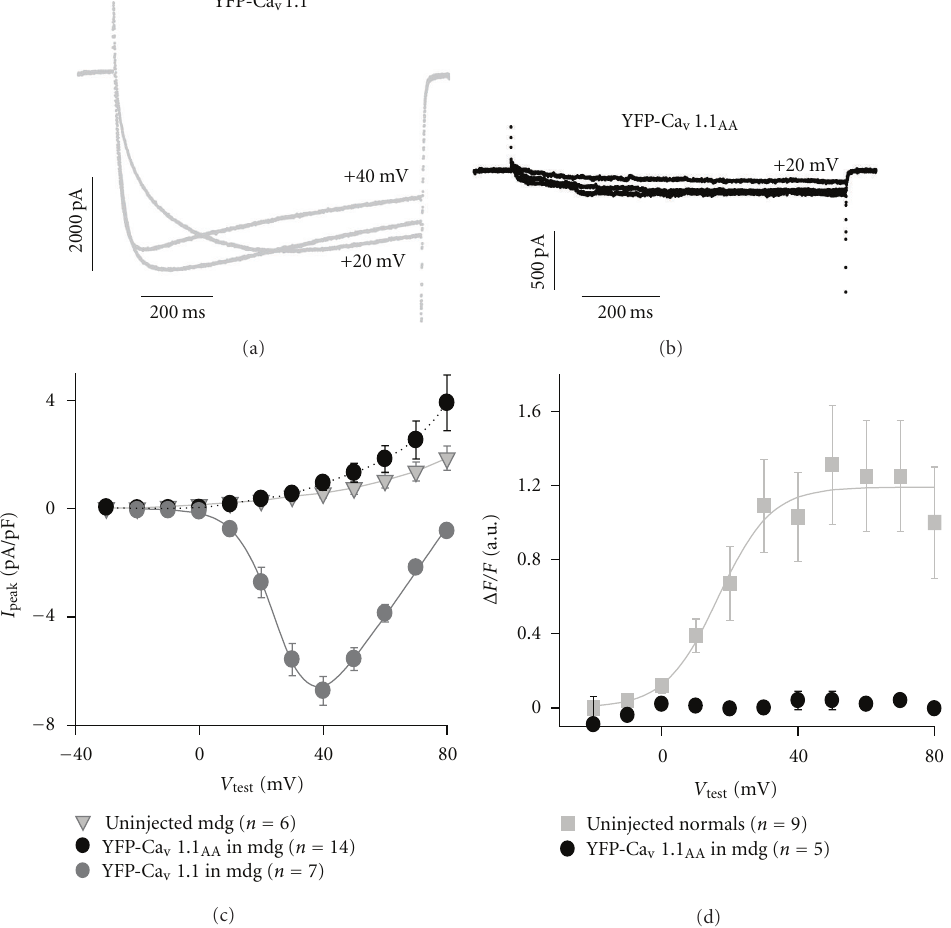
Figure 2: The IQ/AA mutation disables function of Ca v 1.1 as a Ca 2+ channel and voltage sensor for EC coupling. Representative whole-cell L-type Ca 2+ currents recorded from dysgenic myotubes expressing either (a) YFP-Ca v 1.1 (cell 1 (05-10-02); linear capacitance C = 587 pF) or (b) YFP-Ca v 1.1 AA (cell 1 (01-13-03); linear capacitance C = 201 pF). Note that the current scales are di ff erent in (a) and (b). (c) The average peak current density ( I peak ) is plotted as a function of membrane potential ( V test ). Data were obtained from the indicated number of myotubes for each group. The smooth lines through the data were generated by using equation (1) (see Methods) and the average values. (d) The average peak fluorescence ( Δ F/F ) is plotted as a function of membrane potential ( V test ). Data were obtained from the indicated number of myotubes for each group. The smooth lines through data represent Boltzmann fits to the average data using equation (3) (see